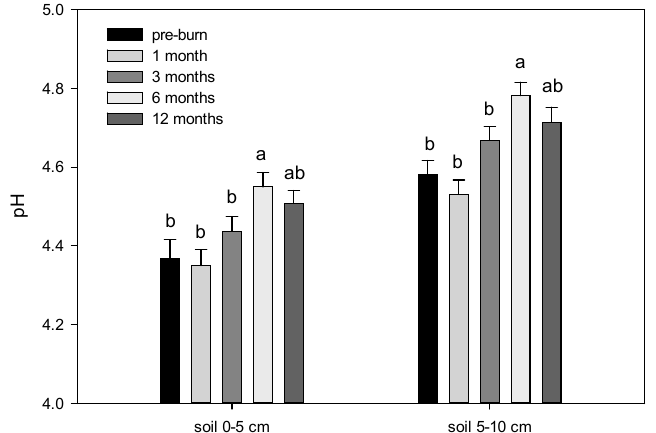
Figure 6. Soil pH from samples collected pre-burn, followed by collections at 1, 3, 6, and 12 months after the fire. Within each group, means with the same letter do not differ at p < 0.05 and error bars represent the standard error of the mean.